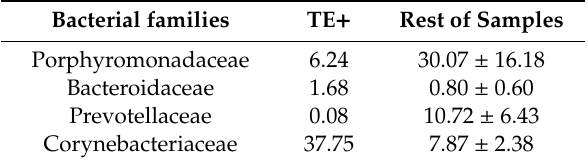
Table 3. Mean values for Porphyromonadaceae, Bacteroidaceae, Prevotellaceae and Corynebacteriaceae families of the TE+ sample and the first batch of samples without TE+.